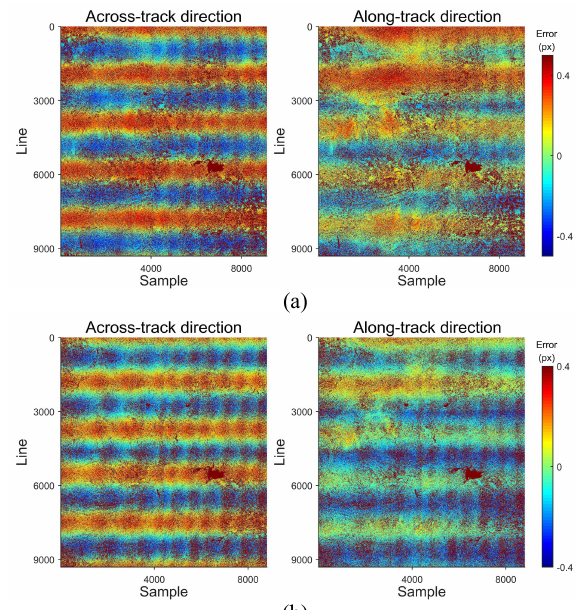
Figure 6. Parallax maps obtained with (a) B1-B2 used and (b)